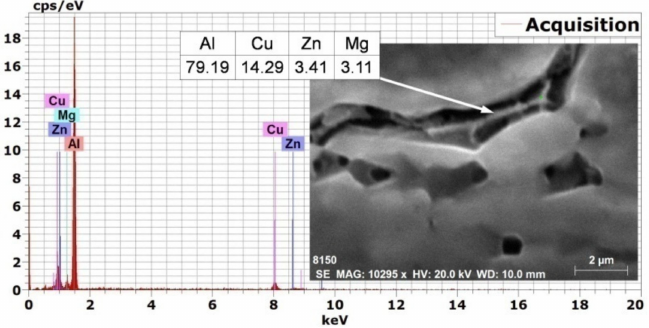
Figure 10. EDS microanalysis of the interdendritic white phase of the high heat input